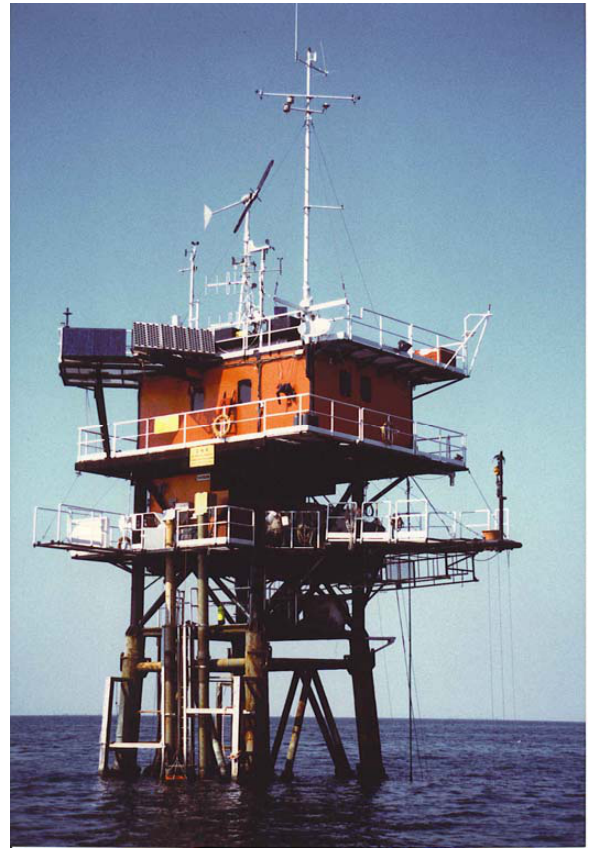
Figure 5 – The ISMAR oceanographic tower. See Figure 2 for its position. The upper terrace is 12.5 Fig. 5. The ISMAR oceanographic tower. See Fig. 2 for its position. metre off the mean sea level. The upper terrace is 12.5m off the mean sea level.